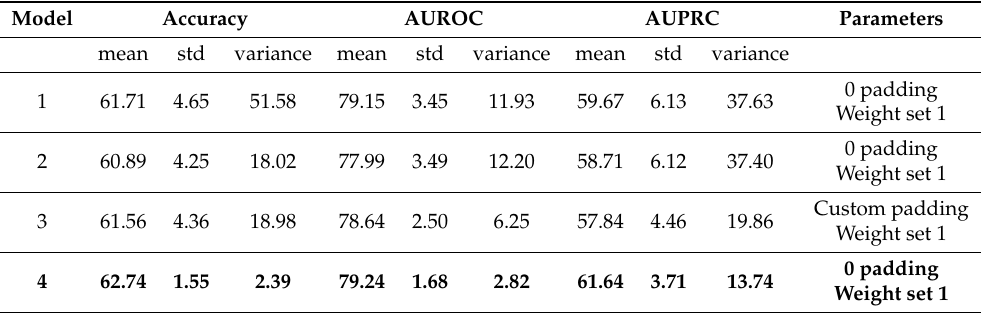
Table 2. Results of 10-fold CV of the best models. In bold the best model according to the selected metrics.